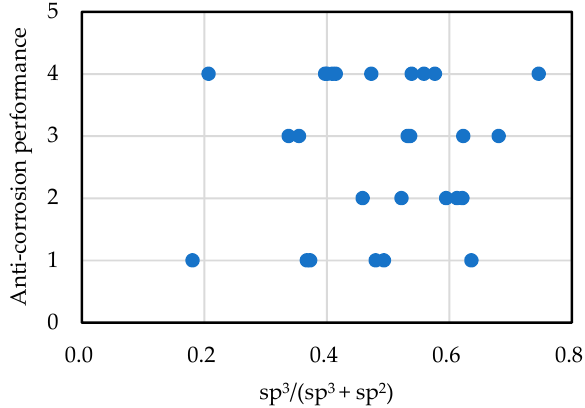
Figure 6. Relationship between the anti-corrosion performance and sp 3 ratio of amorphous carbon films.